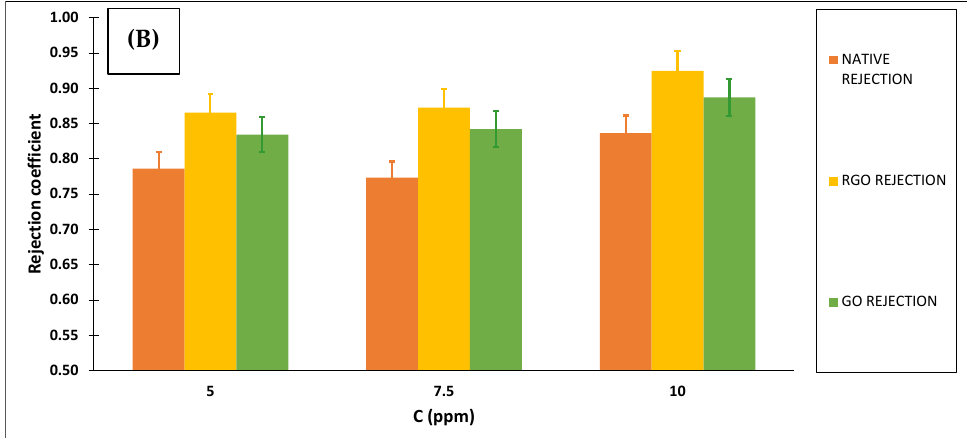
Figure 7. Permeate mass flows ( A ) and rejection coefficients ( B ) obtained at a pressure of 15 bar using ibuprofen solutions of different concentrations.